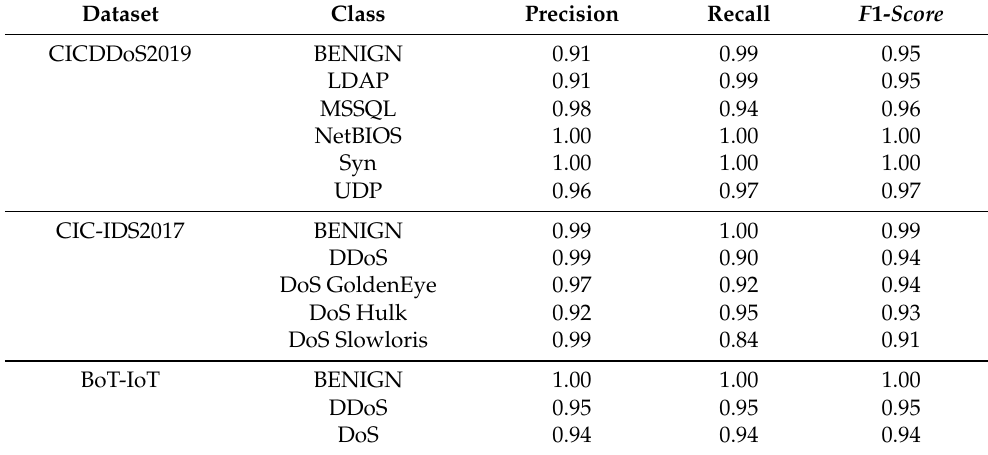
Table 5. Performance